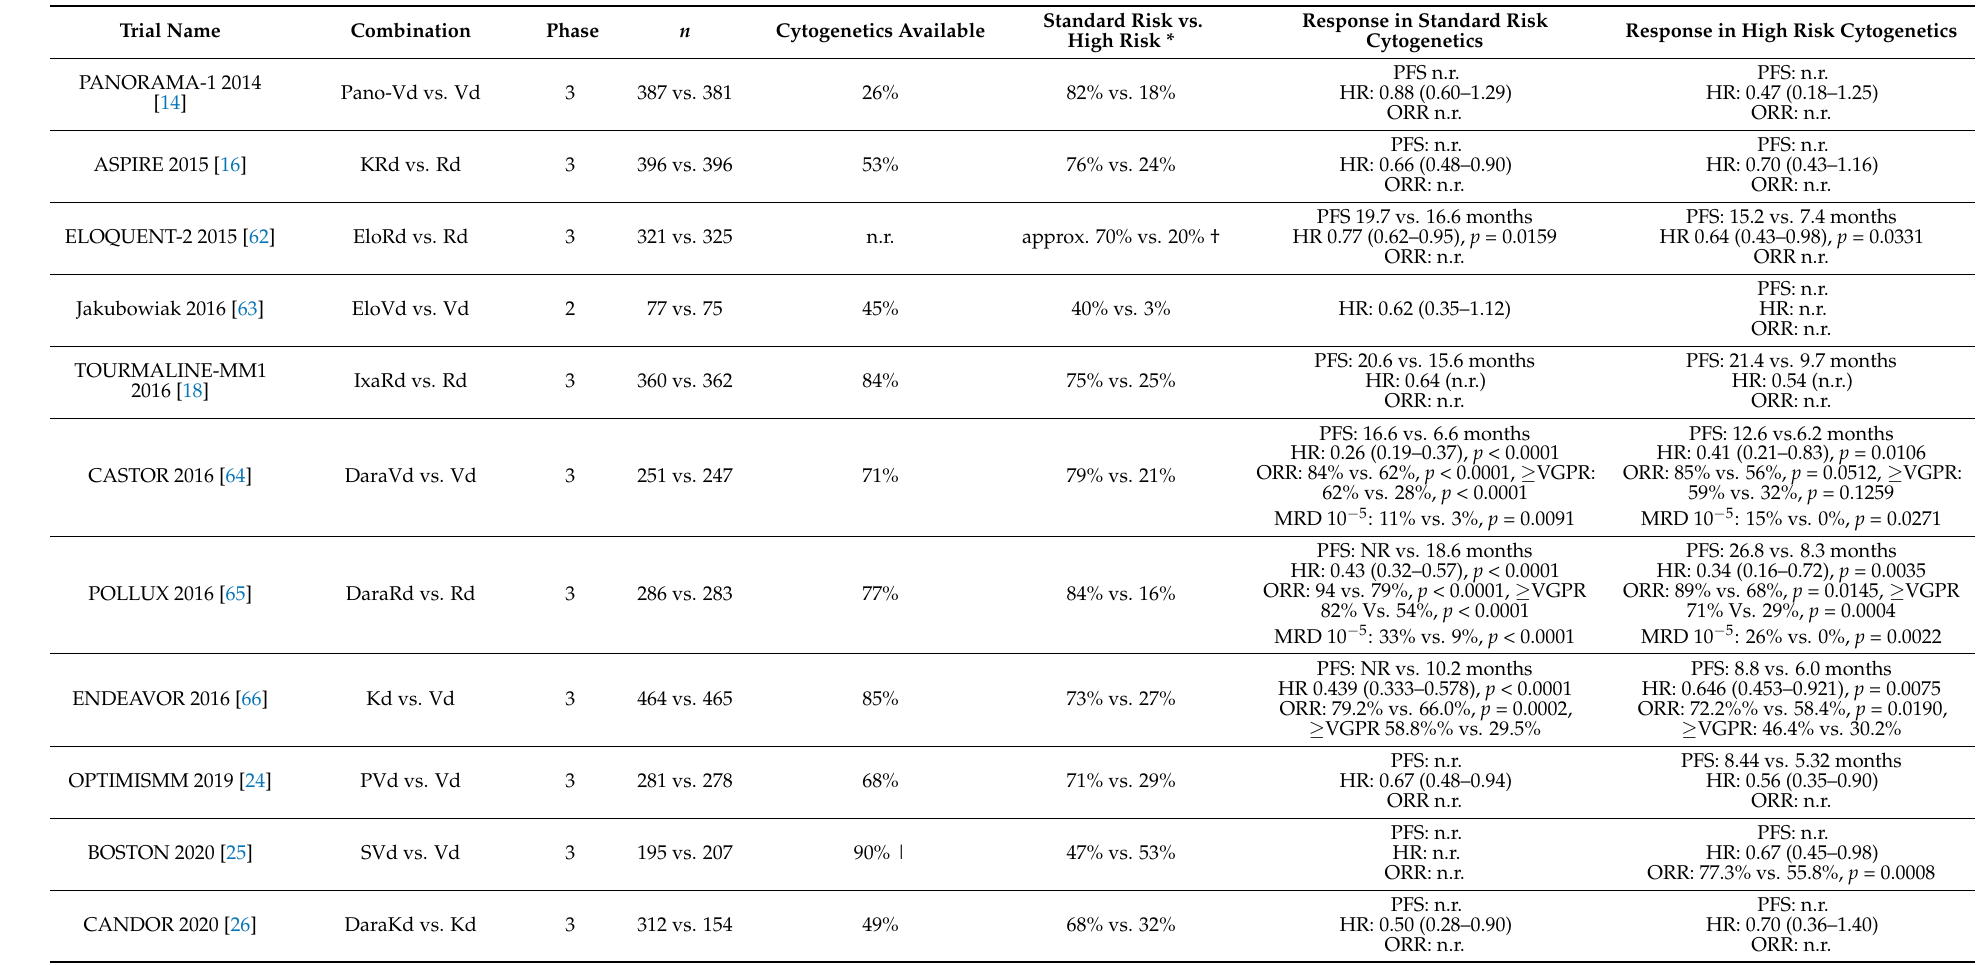
Table 3. Response rates of recent landmark trials according to cytogenetic risk